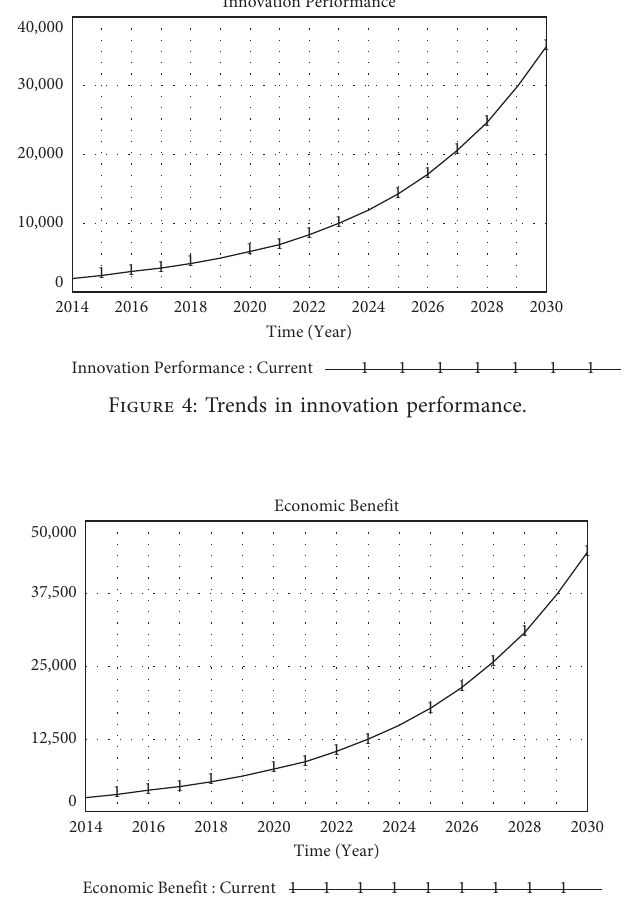
Figure 7: The influence of technical factors adjustment on eco- nomic benefits.